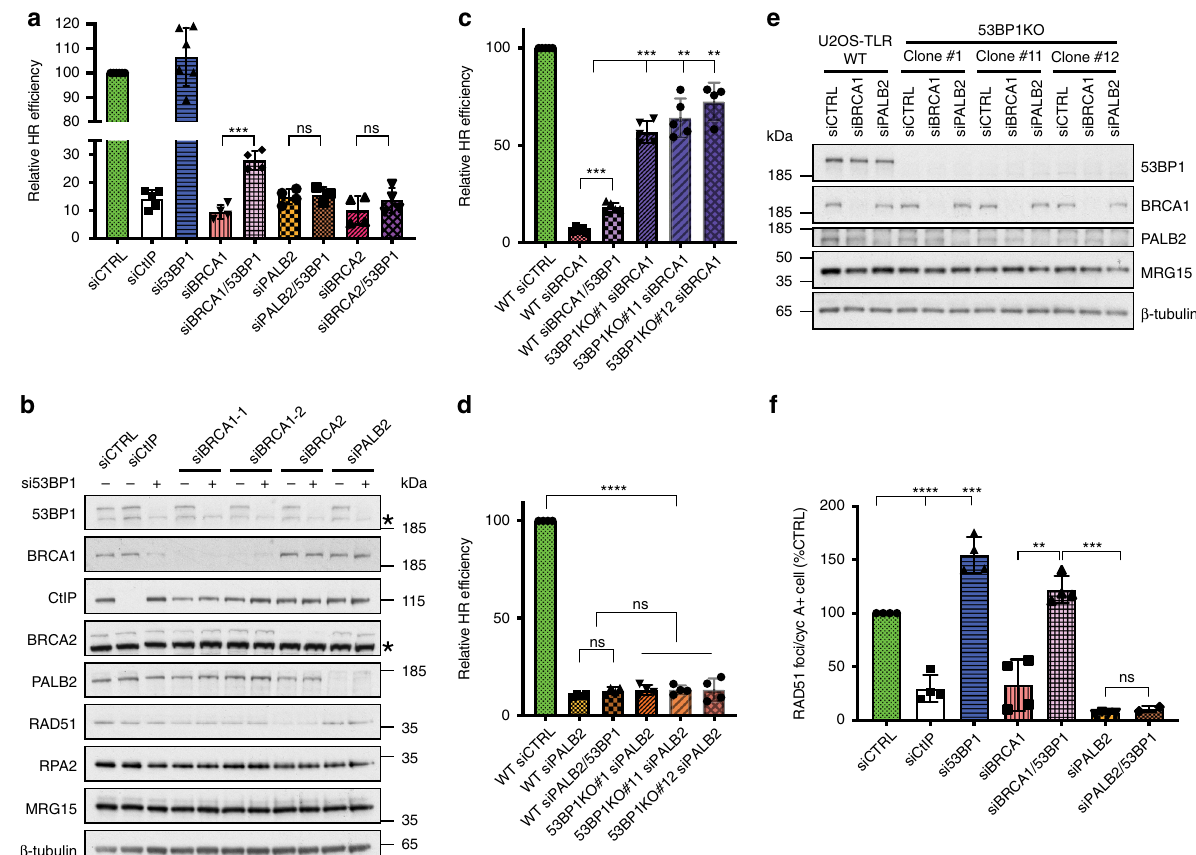
Fig. 1 53BP1 loss corrects HR in BRCA1- but not in PALB2- or BRCA2-de fi cient cells. a HR reporter assay in U2OS-TLR WT cells siRNA-depleted for indicated proteins or treated with a control siRNA (siCTRL). The bars represent mean ± st.dev.; unpaired t test analyses were conducted to determine if differences between samples were statistically signi fi cant; n ≥ 3 experiments. Individual data points are plotted over bars. b Immunoblot of extracts of U2OS-TLR cells depleted for indicated proteins and used in HR assays shown in ( a ). Asterisks mark nonspeci fi c bands. c , d Comparison of HR ef fi ciencies measured by TLR assays performed in U2OS-TLR WT and 53BP1 KO cells siRNA-depleted for either BRCA1 ( c ) or PALB2 ( d ). Data representation and statistical analyses are as in ( a ); n ≥ 4 experiments. e Immunoblot of extracts of U2OS-TLR WT and 53BP1 KO cells siRNA-depleted for BRCA1 and PALB2 and used in HR assays in ( c , d ). f Quanti fi cation of RAD51 IRIF in RPE1 cells siRNA-depleted for indicated proteins. Cells were treated with 6 Gy of IR, fi xed at 4 − 8 h after irradiation, stained with antibodies speci fi c to cyclin A and RAD51 proteins, imaged and quanti fi ed using OPERA Phoenix HT microscope; n = 4 repeats. Source data are provided as a Source Data fi le. ** P < 0.01, *** P < 0.001, **** P < 0.0001; ns, not signi fi cant ( P ≥